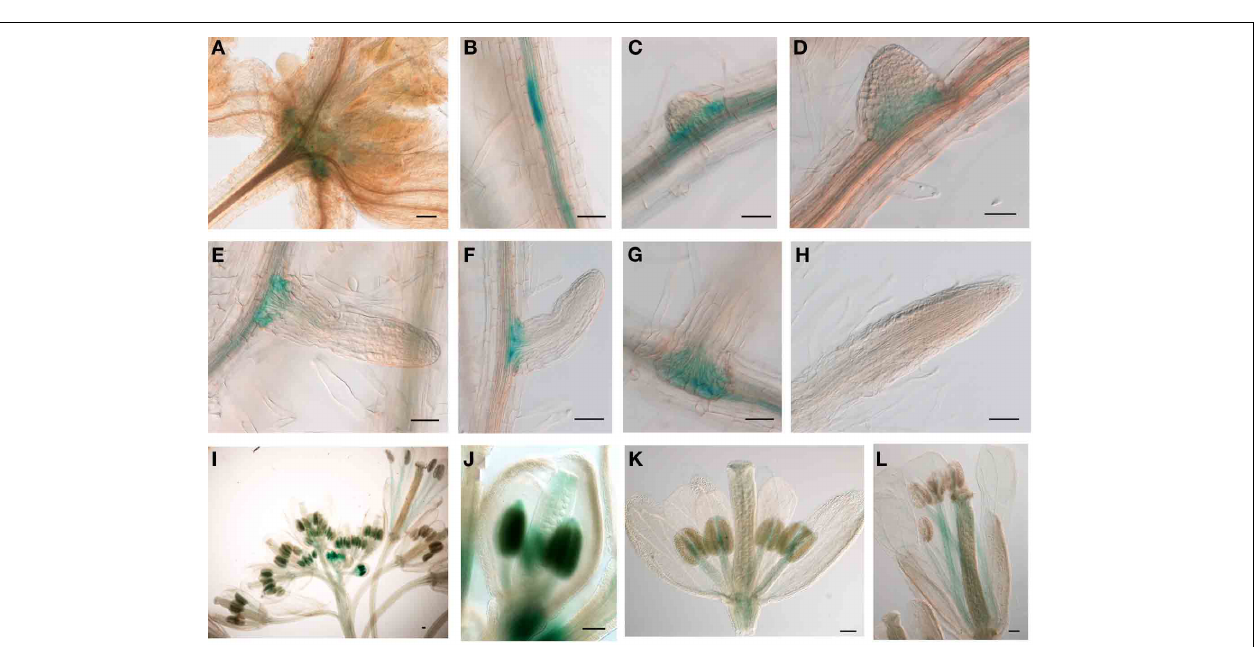
FIGURE 1 | The 2.0kb promoter activity of JMJ15 in transgenic plants. In seedlings, the GUS activity was detected in the base of rosette leaves (A) , root vascular tissues (B) , and bases of growing lateral roots (C–G) , but not in